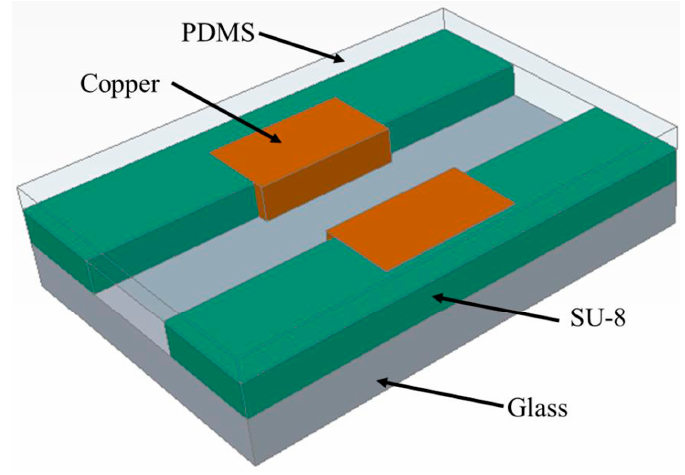
Figure 1. The 3D model of the microfluidic device for impedance measurement.